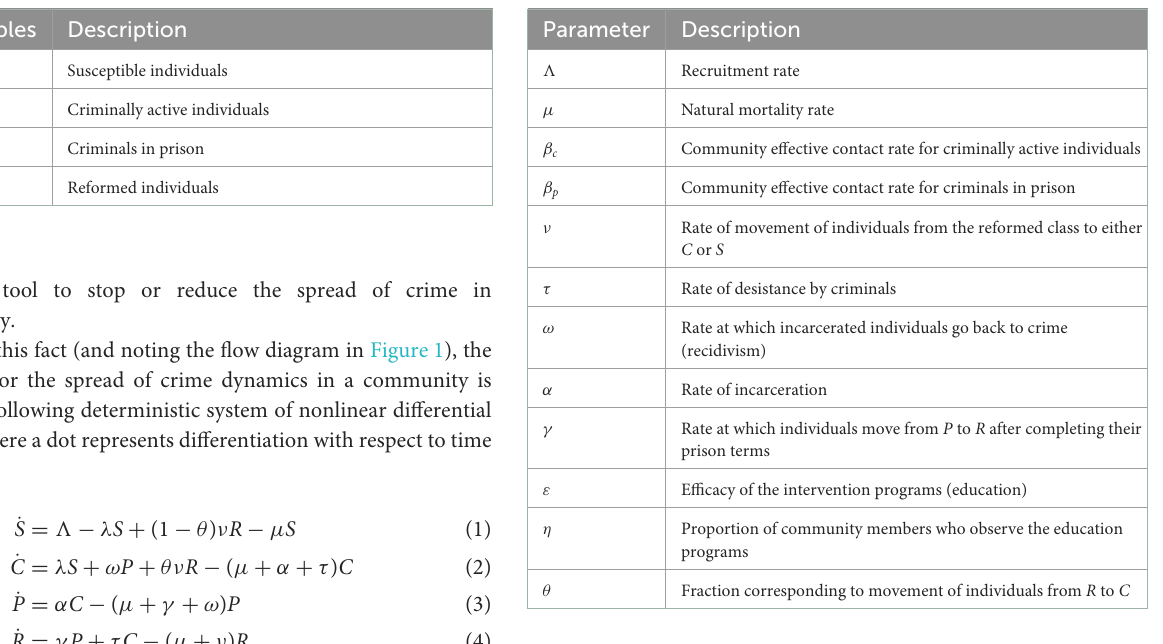
TABLE 1 Description of state variables of the model (Equations 1–4). TABLE 2 Description of parameters of the model (Equations